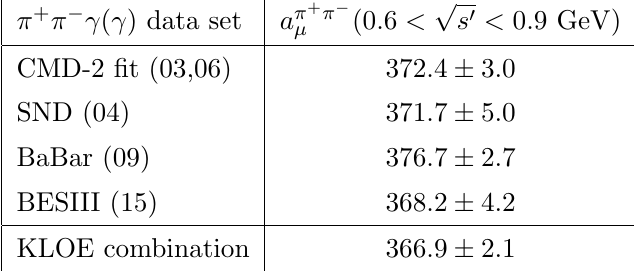
Table 3. Comparative results of the values obtained for a (cid:25) + (cid:25) (cid:0) KLOE combination and the CMD-2, SND, BaBar and BESIII data. The available CMD-2 data have been combined following the prescription of [12]. Results for a (cid:25) + (cid:25) (cid:0) 10 (cid:0) 10 . In all cases, the uncertainties shown are the statistical and systematic uncertainties summed in